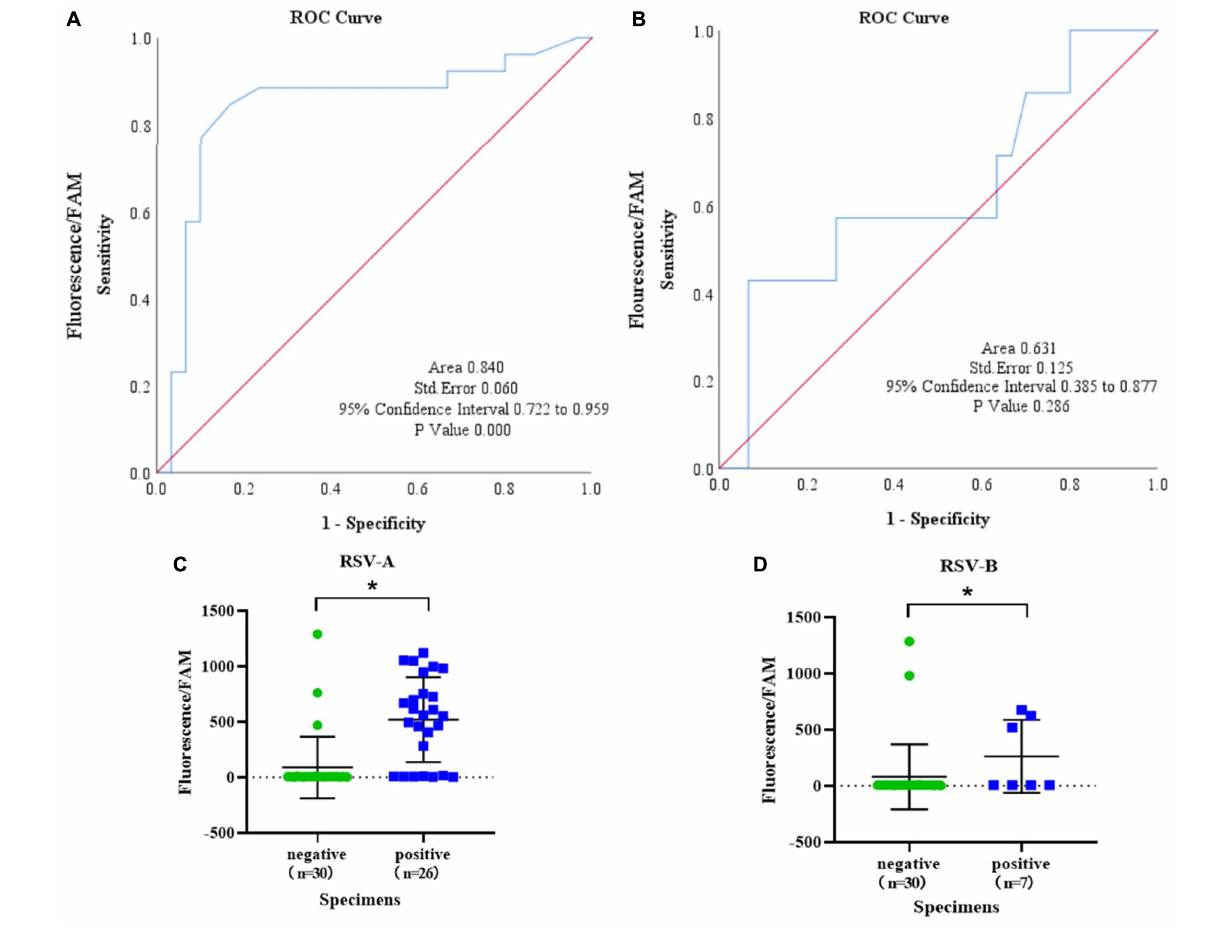
FIGURE 6 | The IT-RAISE system detects RSV in clinical specimens. A ROC curve and scatter diagram for RSV A detection were generated using IT-RAISE system (A,C) . A ROC curve and scatter diagram for RSV B detection were generated using IT-RAISE system (B,D) . * p < 0.05 indicates a statistically significant difference. All experiments were repeated three times ( n =